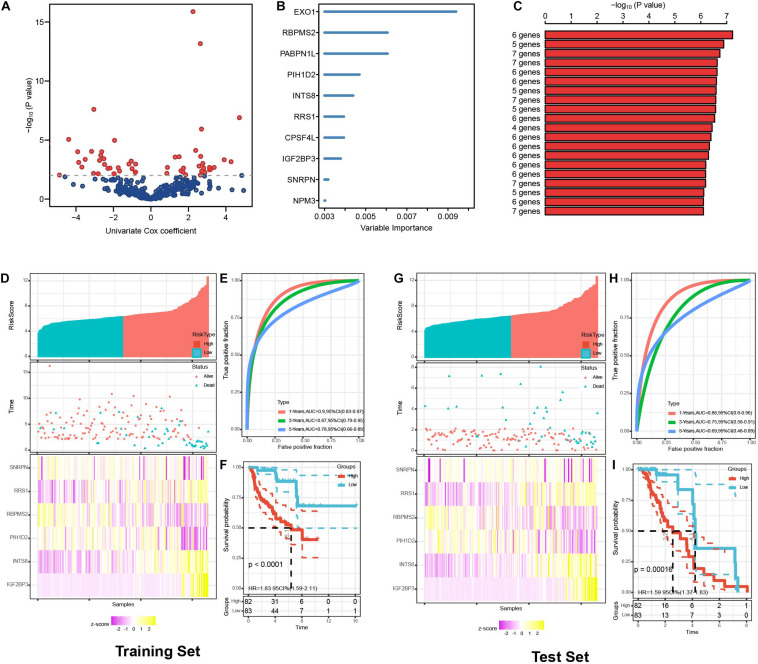
Identification of prognosis-related RBPs and validations of prognostic risk score model in training set and test set. (A) Volcano plot represented the prognosis-related RBPs of univariate Cox regression analysis. (B) Random survival forest analysis filtered out 10 best related genes. (C) The top 20 signatures were screened out among 1023 combinations according to the P value of Kaplan–Meier analysis. The risk score distribution, survival status distribution and heatmap of six RBPs expression in the training set (D) and test set (G). ROC analysis for predictive OS of pRCC patients at 1, 3, and 5 years in the training set (E) and test set (H). Kaplan–Meier analysis for overall survival (OS) of different risk groups in the training set (F) and test set (I).